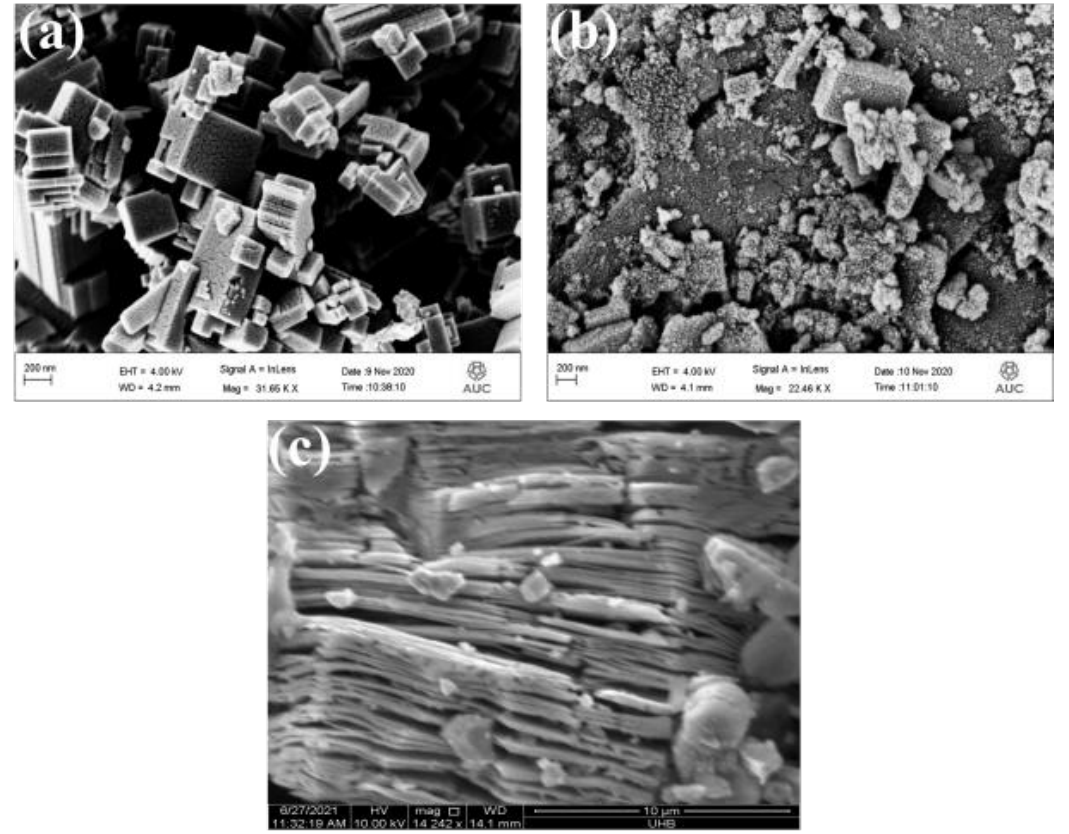
Figure 4. FE SEM images of ( a ) WO 3 , ( b ) WO 3 /MXene nanocomposite and ( c ) MXene. Figure 4. FESEM images of ( a ) WO 3 , ( b ) WO 3 /MXene nanocomposite and ( c ) Energy-dispersive X-ray analysis (EDX) was used for the elemental analysis of the synthesized material. Figure 5a,b show the elemental composition of WO 3 and WO 3 /MXene composites, respectively, which confirmed the purity of the as-synthesized samples.